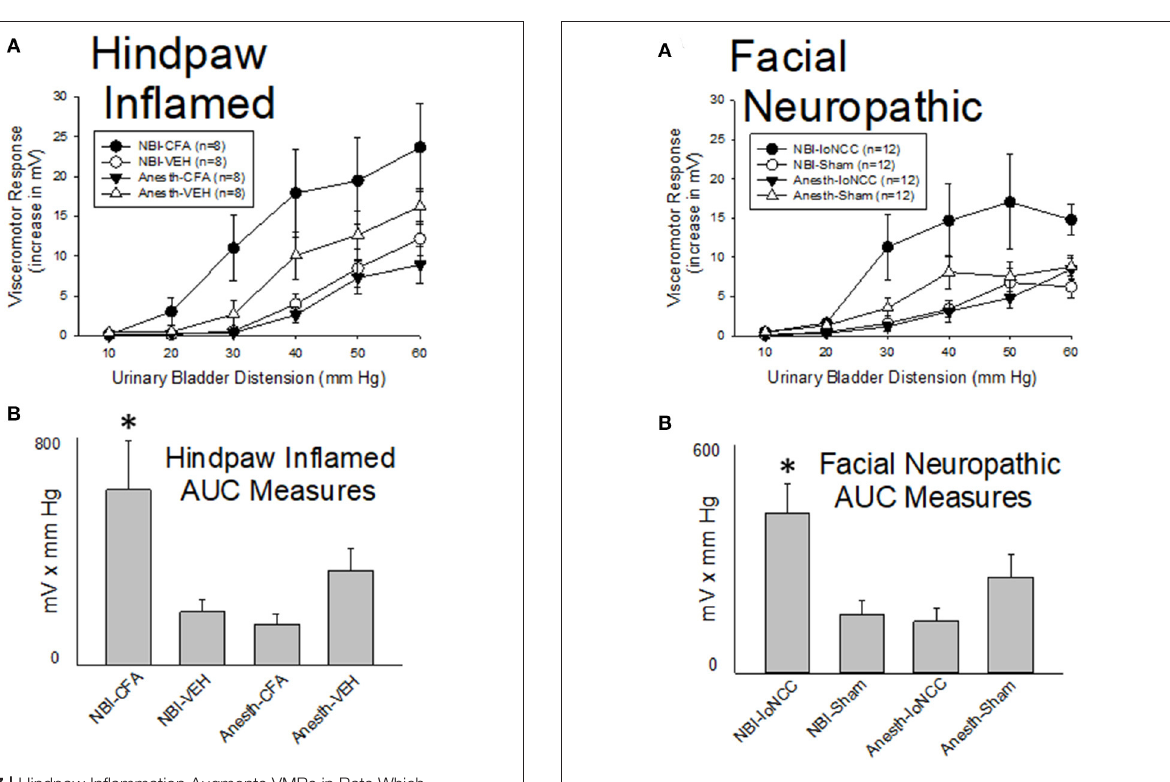
FIGURE 8 | Facial Neuropathic Nociception Augments VMRs in Rats Which Experienced NBI. Presentation is similar to that of Figures 2 – 6 (group stimulus-response functions in (A) ; Area-Under-the-Curve, AUC, measures in (B) ). Rats which had experienced NBI demonstrated statistically greater VMRs to UBD compared with controls when they also experienced InfraOrbital Nerve Chronic Compression (IoNCC) as a second insult as adults. “Sham” indicates sham surgery as an adult control procedure. *indicates VMRs in the NBI-IoNCC group was statistically more robust than the NBI-Sham and Anesth-IoNCC groups ( p < 0.05). See text for greater explanation and